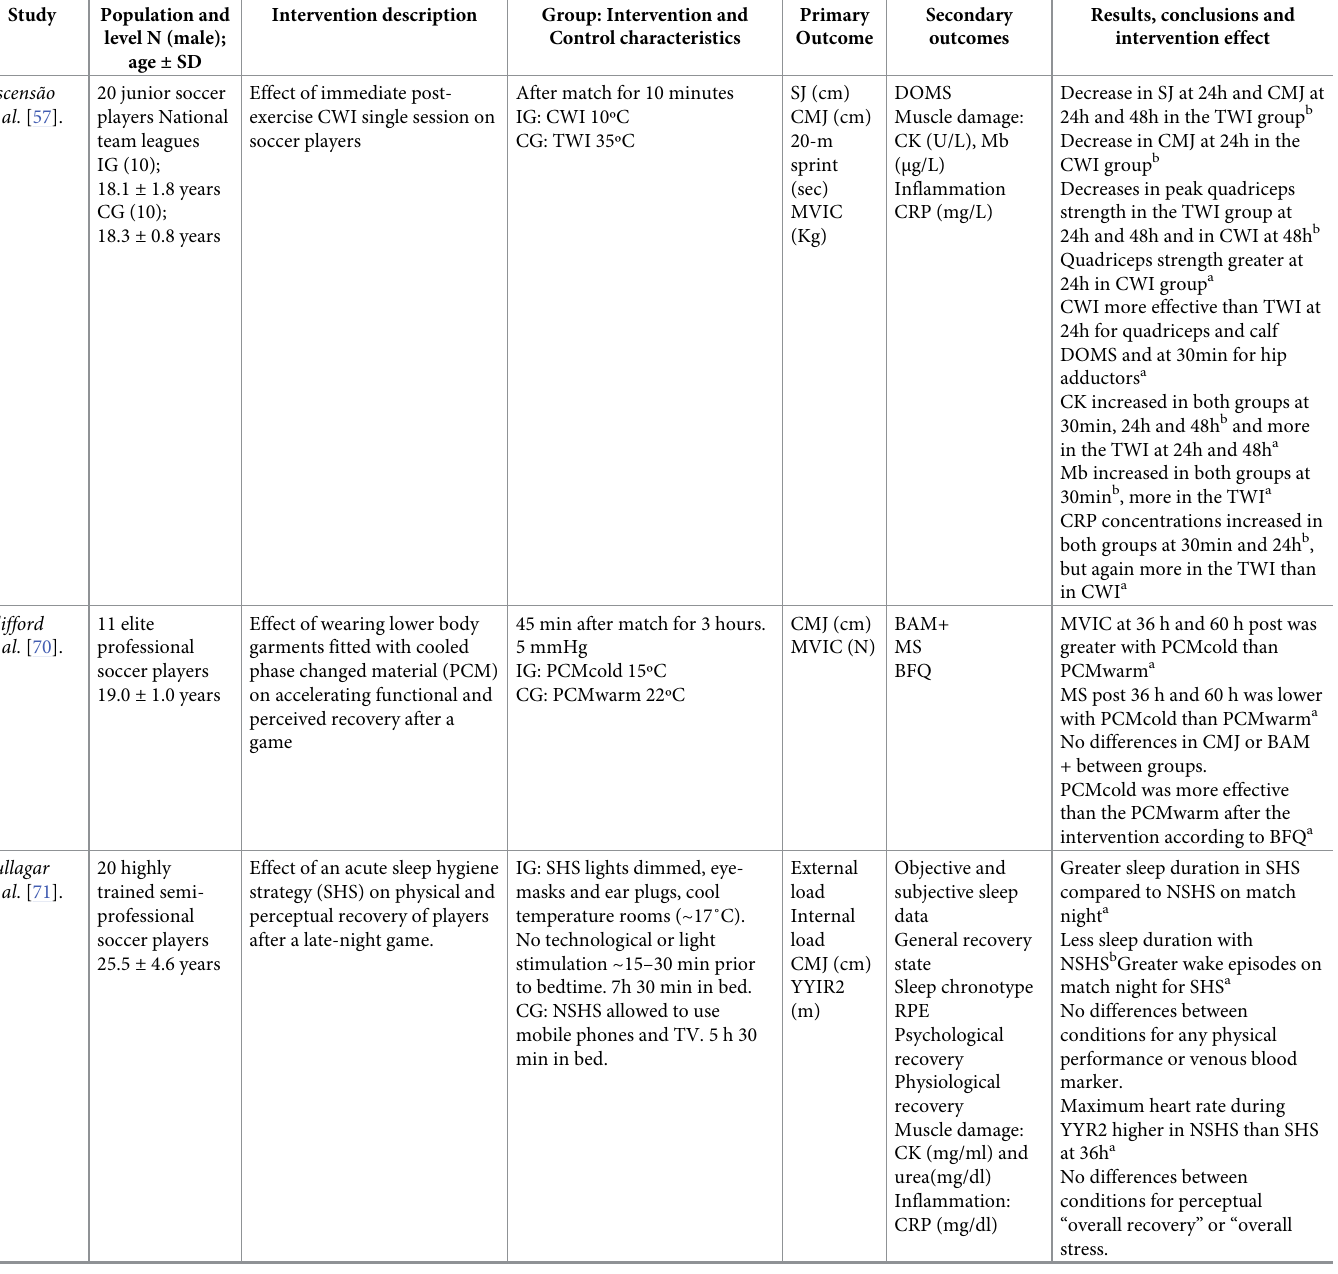
Table 1. Characteristics of the included randomised controlled